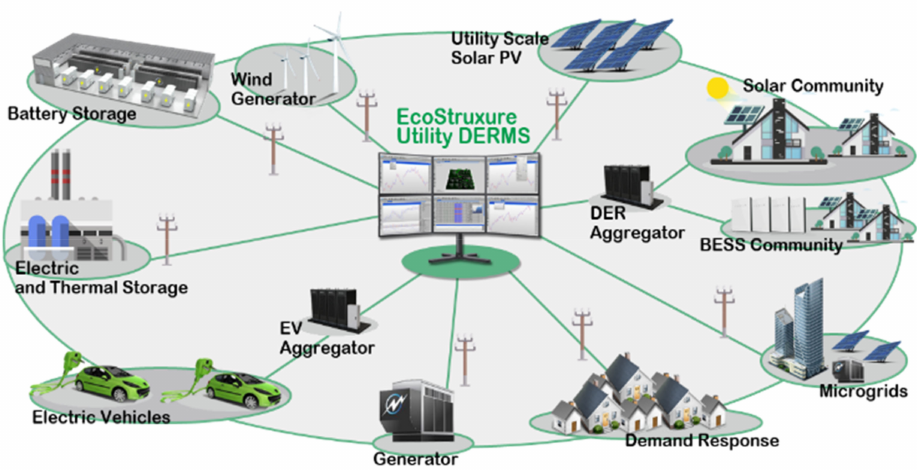
Figure 1. High-level architecture of a utility DERMS